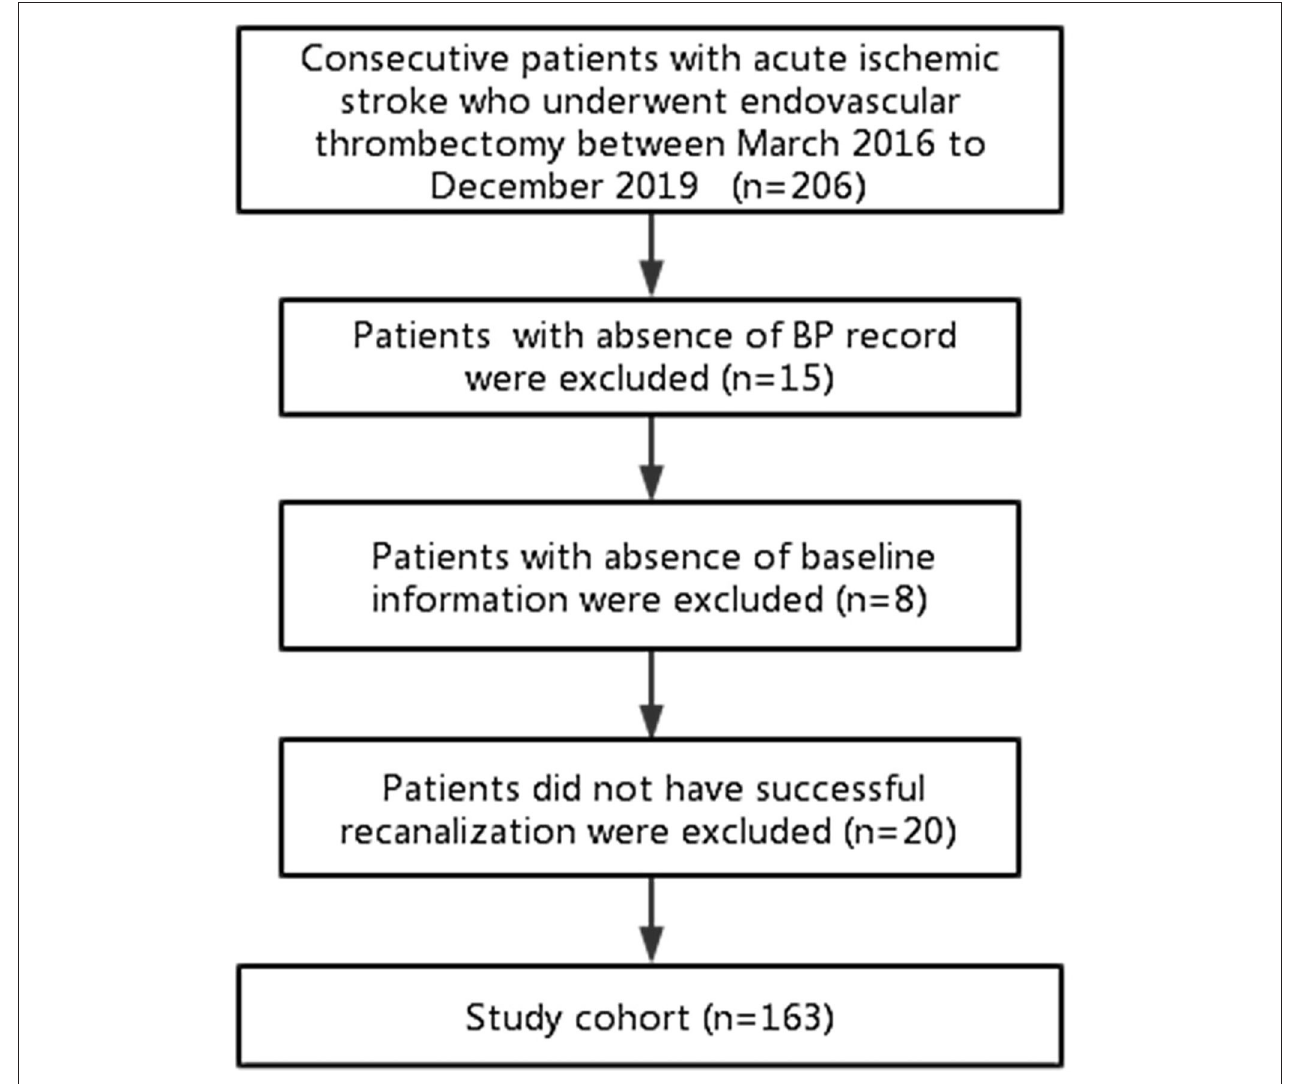
FIGURE 1 | Flowchart of patient